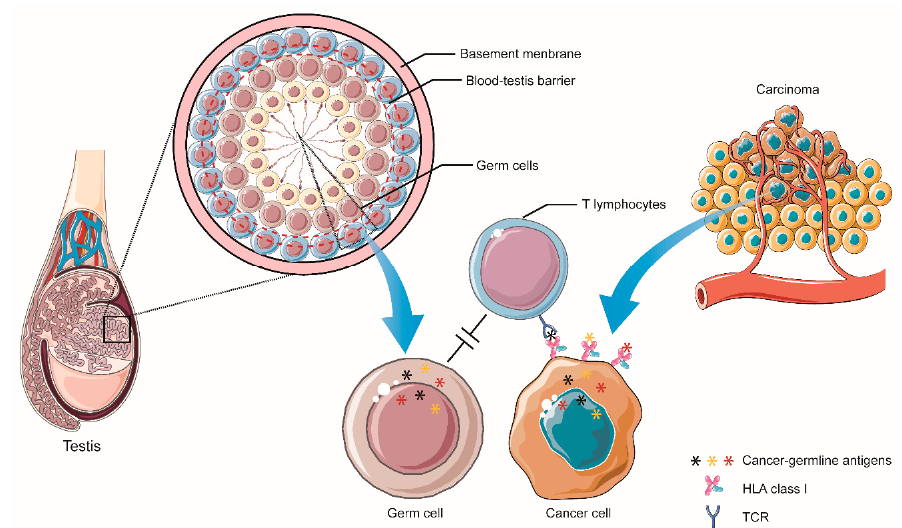
Figure 3. The immunological nature of cancer-germline antigens. The expression of cancer-germline antigens (CGAs) is normally limited to reproductive tissues. The presence of the blood-testis barrier makes testis an immune-privileged zone, which means CGAs expressed in germ cells do not interact with the immune system. Furthermore, due to the lack of HLA class I molecules on the surface of germ cells, CGAs cannot be presented on their cell surface, making germ cells unrecognizable for CGA-specific immune cells. These features make CGAs foreign when exposed to the immune system and endow them with a strong capability to induce a robust immune response. Aberrant expression of CGAs can be detected in various cancers. These antigens, being expressed in malignant cells, will be processed and presented on the surface of malignant cells, including the HLA class I pathway. Once recognized by immune cells, CGAs will be targeted by the immune system, leading to the destruction of CGA-expressing malignant